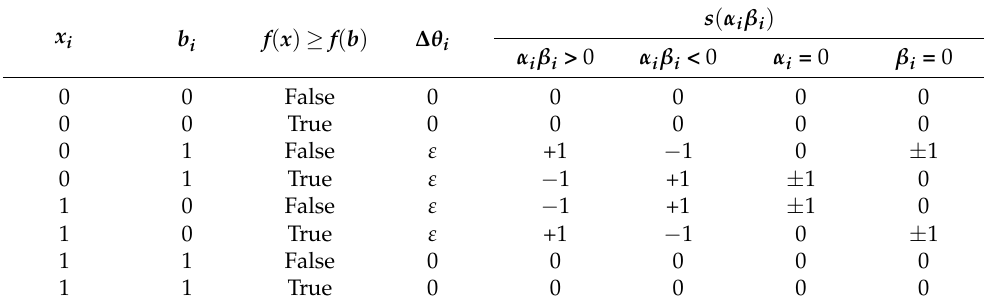
Table 1. Classical Quantum Revolving